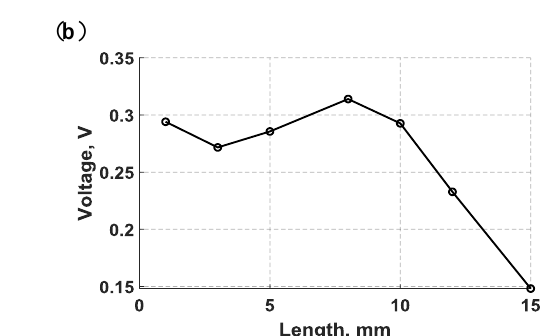
Figure 15. A numerical parametric study varying the length of bondline embedded d35 PZT transducers and actuating a 5-peak tone burst signal at 30 kHz; ( a ) maximum in-plane shear-stress generated by the d35 PZT actuator, and ( b ) maximum voltage produced by the d35 PZT sensor.